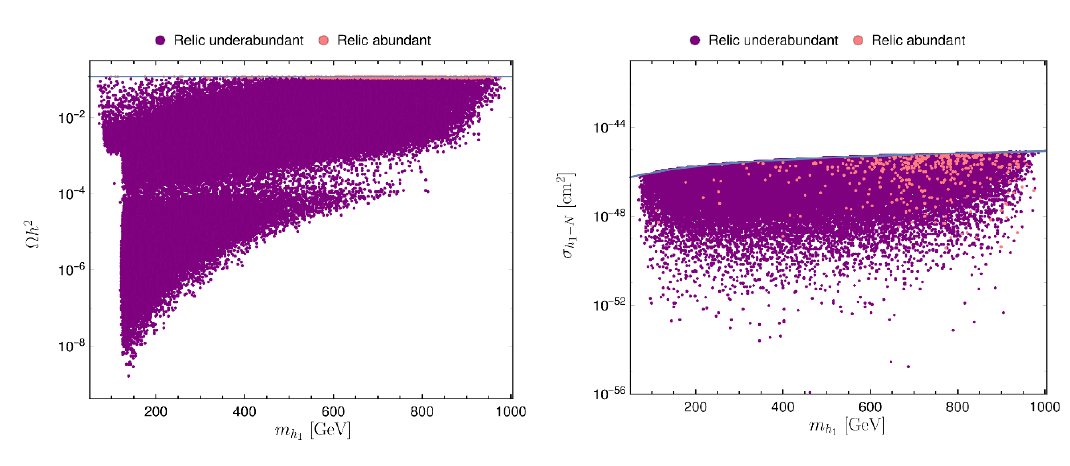
Figure 2. Points that survive all experimental and theoretical constraints. Left: relic density abundance versus dark matter mass where the grey line represents the measured DM relic abun- dance; points either saturate the relic abundance constraints within +1 (cid:27) and -5 (cid:27) around the central value (pink points) or are below the measured central value (violet points). Right: spin-independent nucleon dark matter scattering cross section as a function of the dark matter mass where the grey line represents the latest XENON1T [46, 54] results; colour code is the same and pink points are superimposed on violet